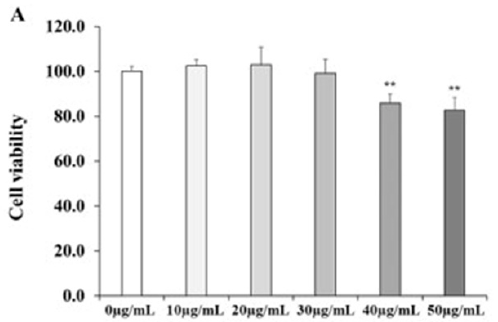
Figure 2. Cell viability after AGE treatment in HDFs. HDFs were treated with different concentrations of AGE, and incubated for 24 h. After incubation, MTT assay was performed to measure the cell viability of AGE ( A ). All data were expressed as the mean ± SD of at least three independent experiments. ** p < 0.01 versus control group.